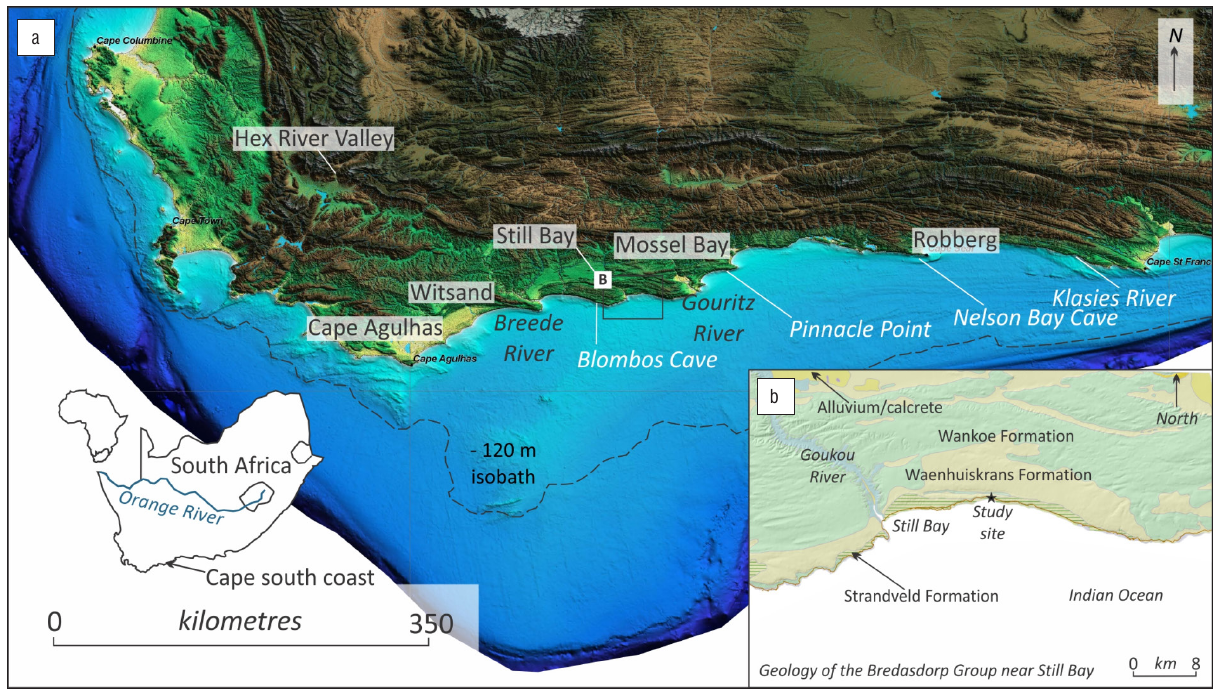
Figure 1: (a) Locality of the study area in the context of the south coast of South Africa. The continental shelf which borders this coastline reaches the broadest extent in South Africa, and the 120-m isobath lies up to 100 km offshore. The relatively shallow and low-gradient Agulhas Bank sweeps from Cape Agulhas in the southwest to Robberg in the east. (b) The dominant geological units at the study site, which are formations of the Bredasdorp Group and were deposited in the Neogene and